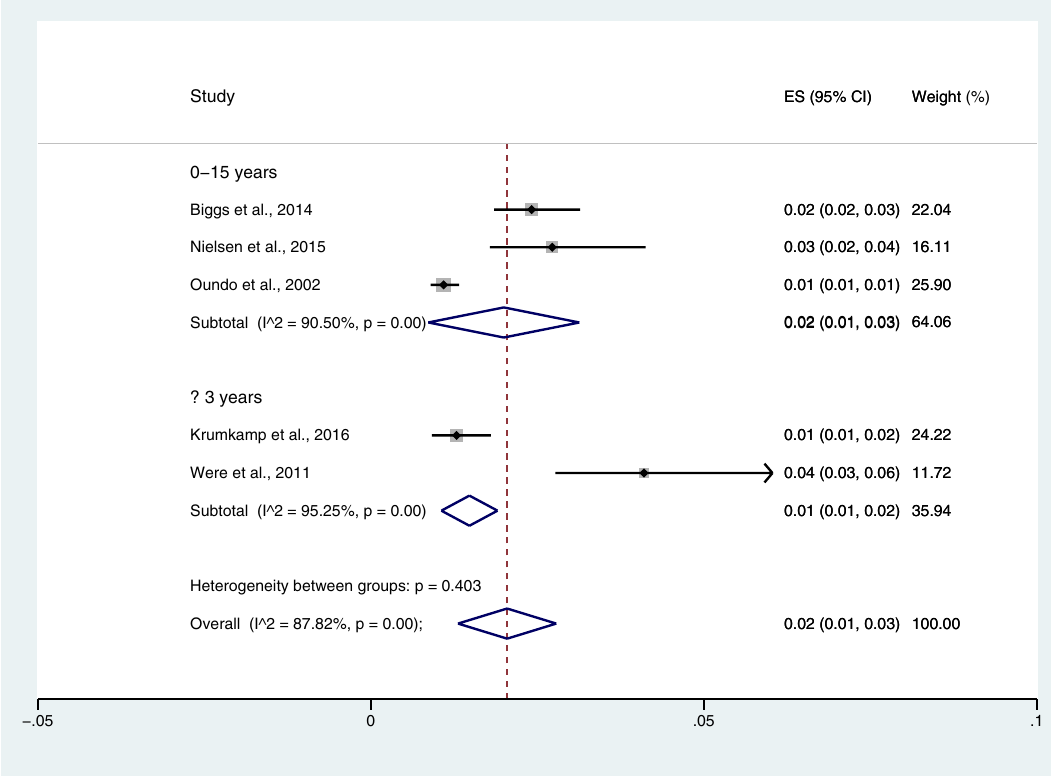
Figure 16. Prevalence of NTS infection among patients with malaria using blood cultures for the identification of Salmonella spp. infection stratified by age groups. ES proportion estimate (multiply 100 units for interpreted as prevalence estimate), CI confidence interval, NS not